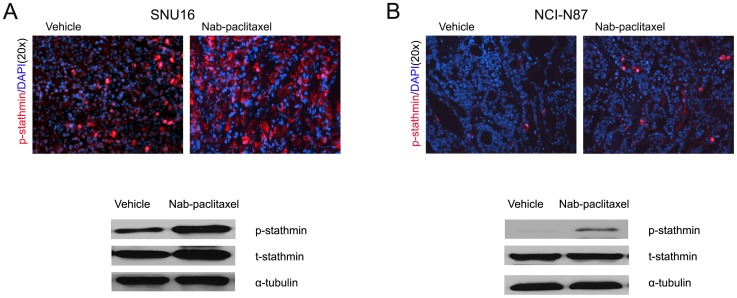
Effects of nab-paclitaxel treatment on expression of phospho-stathmin in vivo.SCID mice were subcutaneously injected SNU16 cells (20×106) or NCI-N87 cells (10×106) and treated with nab-paclitaxel for 2 weeks. Intratumoral expression of phospho-stathmin was measured in SNU16 (A) or NCI-N87 (B) tumor tissue by immunostaining tissue sections for phospho-stathmin (ser38) antigen and photographed under a fluorescent microscope. Tumor lysates were prepared from tumor tissue samples obtained from SNU16 (A) or NCI-N87 (B) tumor bearing SCID mice after nab-paclitaxel therapy and then analyzed by immunoblotting for phospho-stathmin and total stathmin.